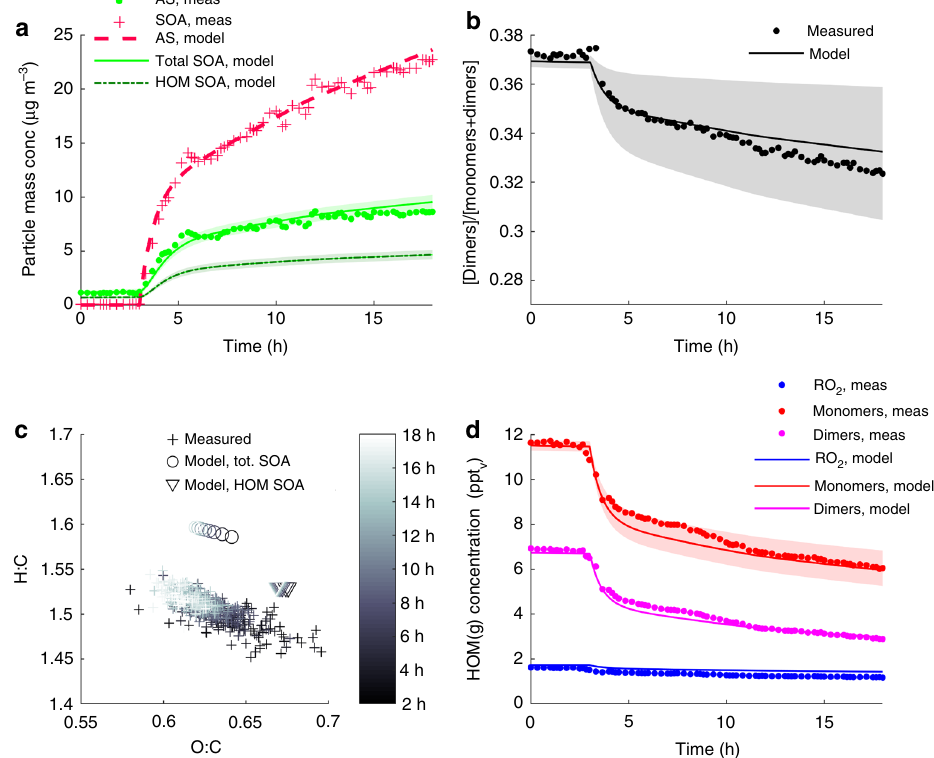
Fig. 2 Highly oxygenated organic molecule (HOM) gas-particle partitioning. Model and measurement results from an α -pinene ozonolysis experiment with ammonium sulfate (AS) seed particles 9 . Panel a shows the modelled and measured secondary organic aerosol (SOA) and AS seed particles mass concentration. b Relative dimer fraction of the total closed shell HOM gas-phase concentration. c SOA elemental composition, and d gas-phase concentrations of closed shell HOM monomers, dimers and peroxy radicals (RO 2 ). The shaded areas in panel a , b and d represent the range of model results obtained when the HOM pure liquid saturation vapour pressures were set to be one order of magnitude higher or lower than the values estimated with the functional group contribution method